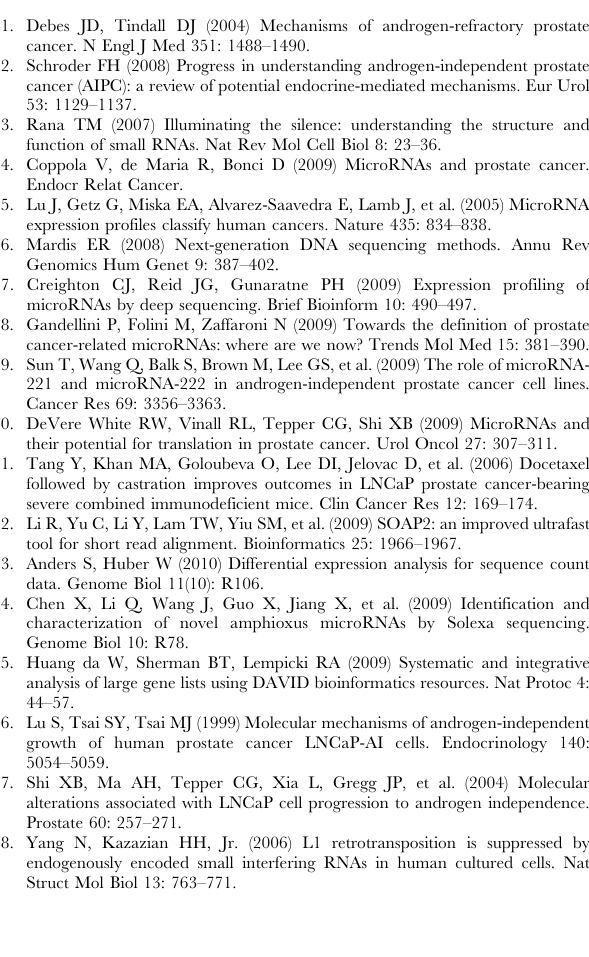
Table S2 The novel miRNAs identified in LNCaP and LNCaP-AI libraries.